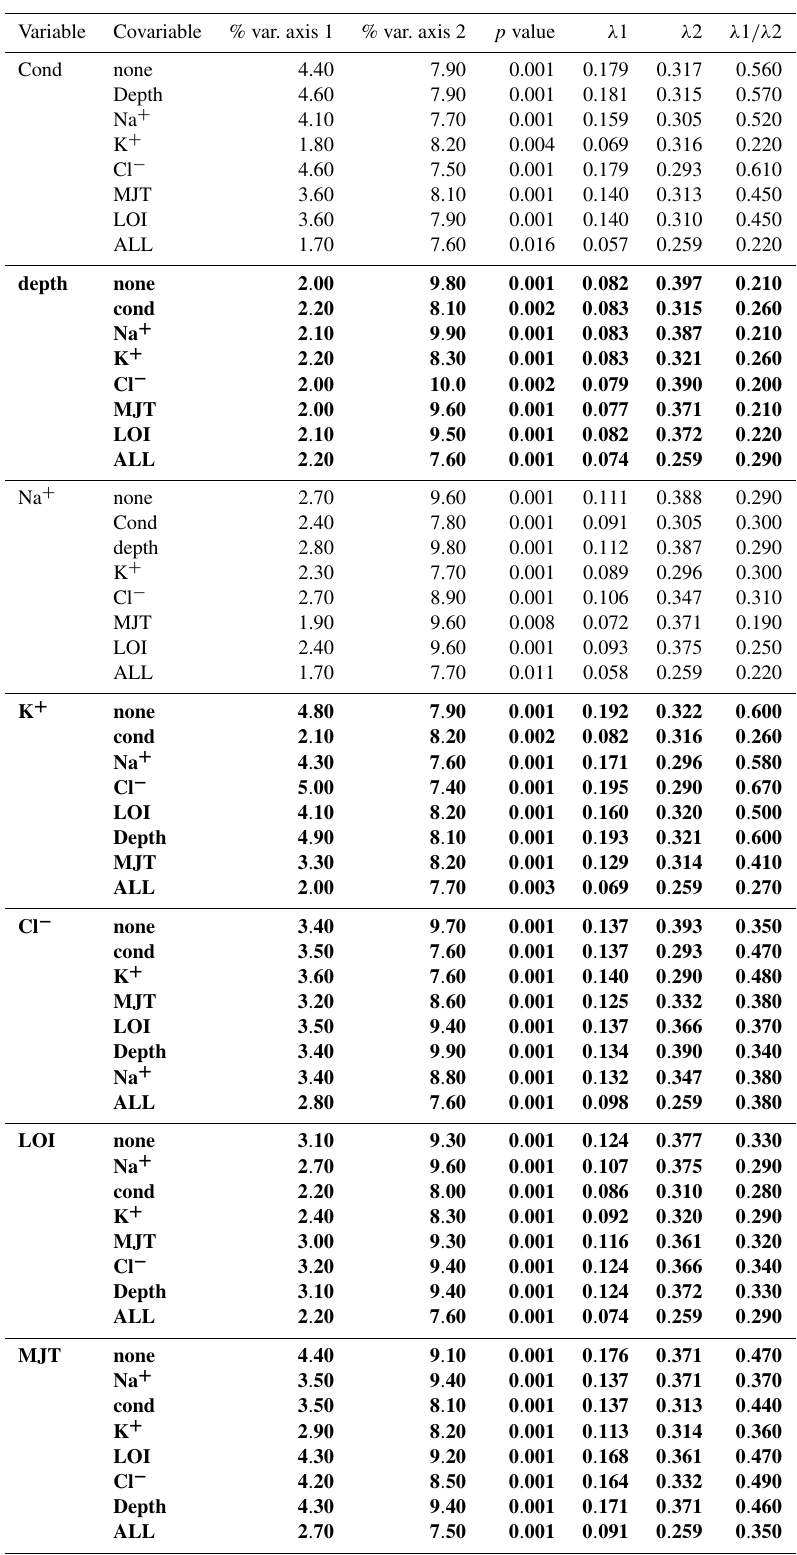
Table 3. Partial canonical correspondence analysis (pCCA) result with environmental variables that showed a significant correlation ( p <0.05) in CCAs with chironomid species data included based on the 100 lakes calibration training set. Depth, K + , Cl − , LOI and MJT (bold) maintained their significance ( p <0.01) after each step of the